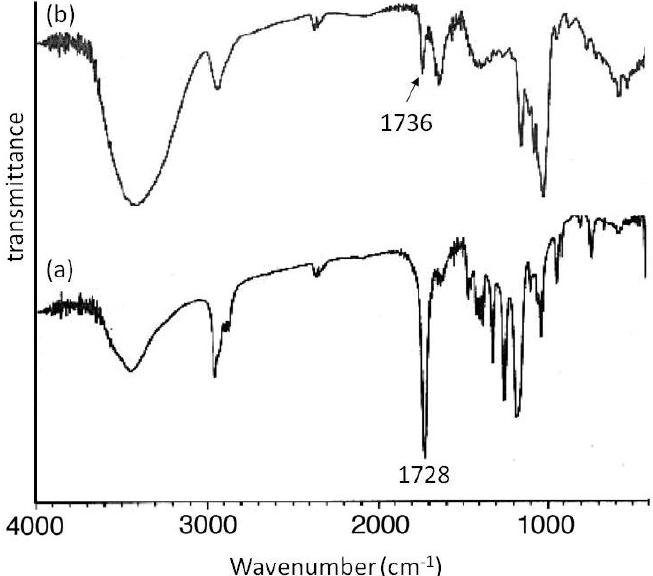
Figure 8. IR spectra of PVL ( a ); and amylose-PVL inclusion complex ( b